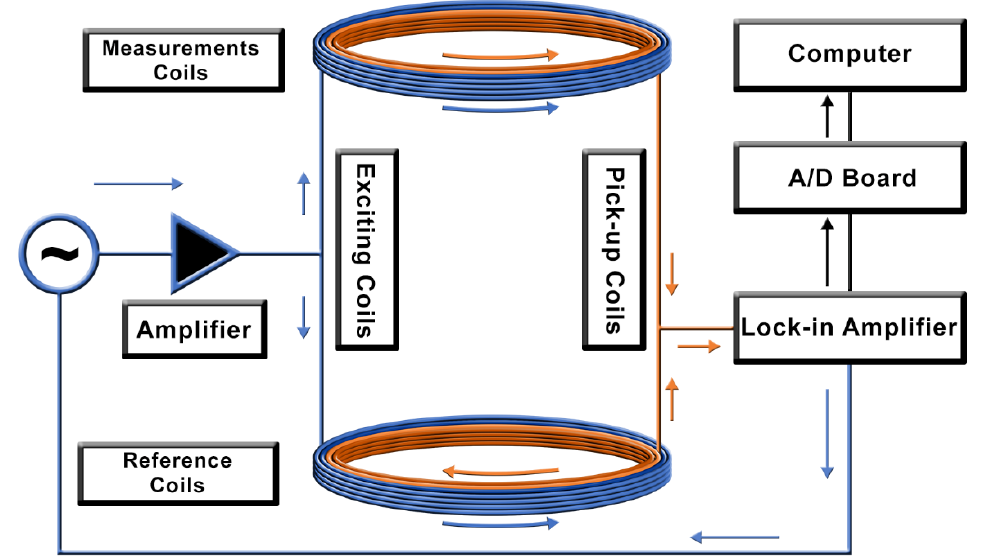
Figure 1. Schematic diagram of the Alternate Current Biosusceptometry (ACB) system. The blue arrows indicate the excitation windings of the coils, and the orange arrows indicate the pick-up windings of the coils.